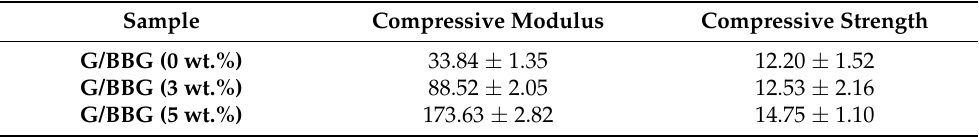
Table 2. Mean values and standard deviations for compressive modulus and compressive strength of the gelatin nanocomposites with different concentrations of borosilicate.